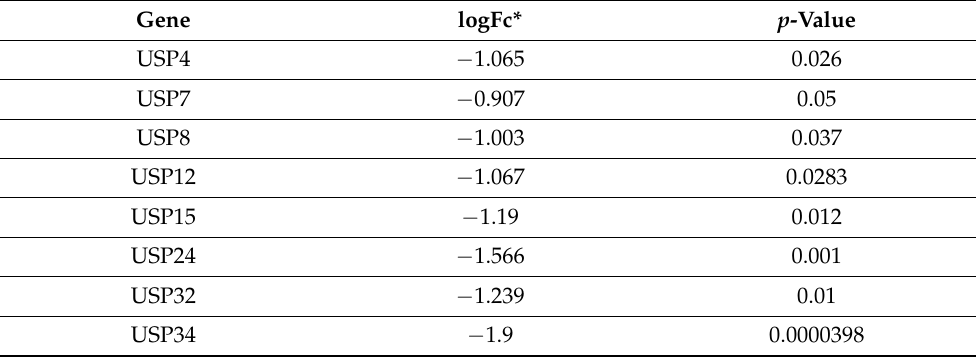
Table 1. Downregulation of deubiquitinases in TQ-treated Jurkat cells as compared with un- treated cells.